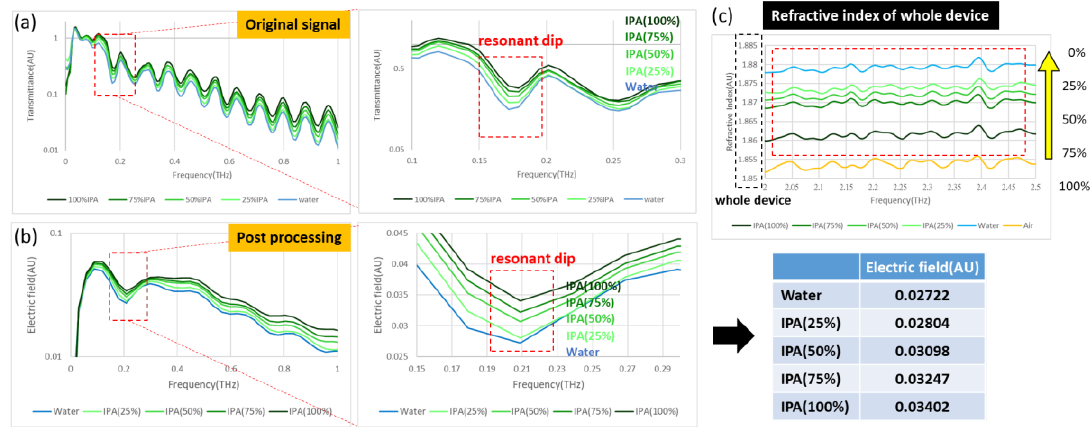
Figure 6. Spectrum of IPA solution at five concentrations: ( a ) Original signal with fluctuation; ( b ) Post- processing signal to eliminate interference; ( c ) Refractive index of the entire device, the value increases as the water ratio rises.